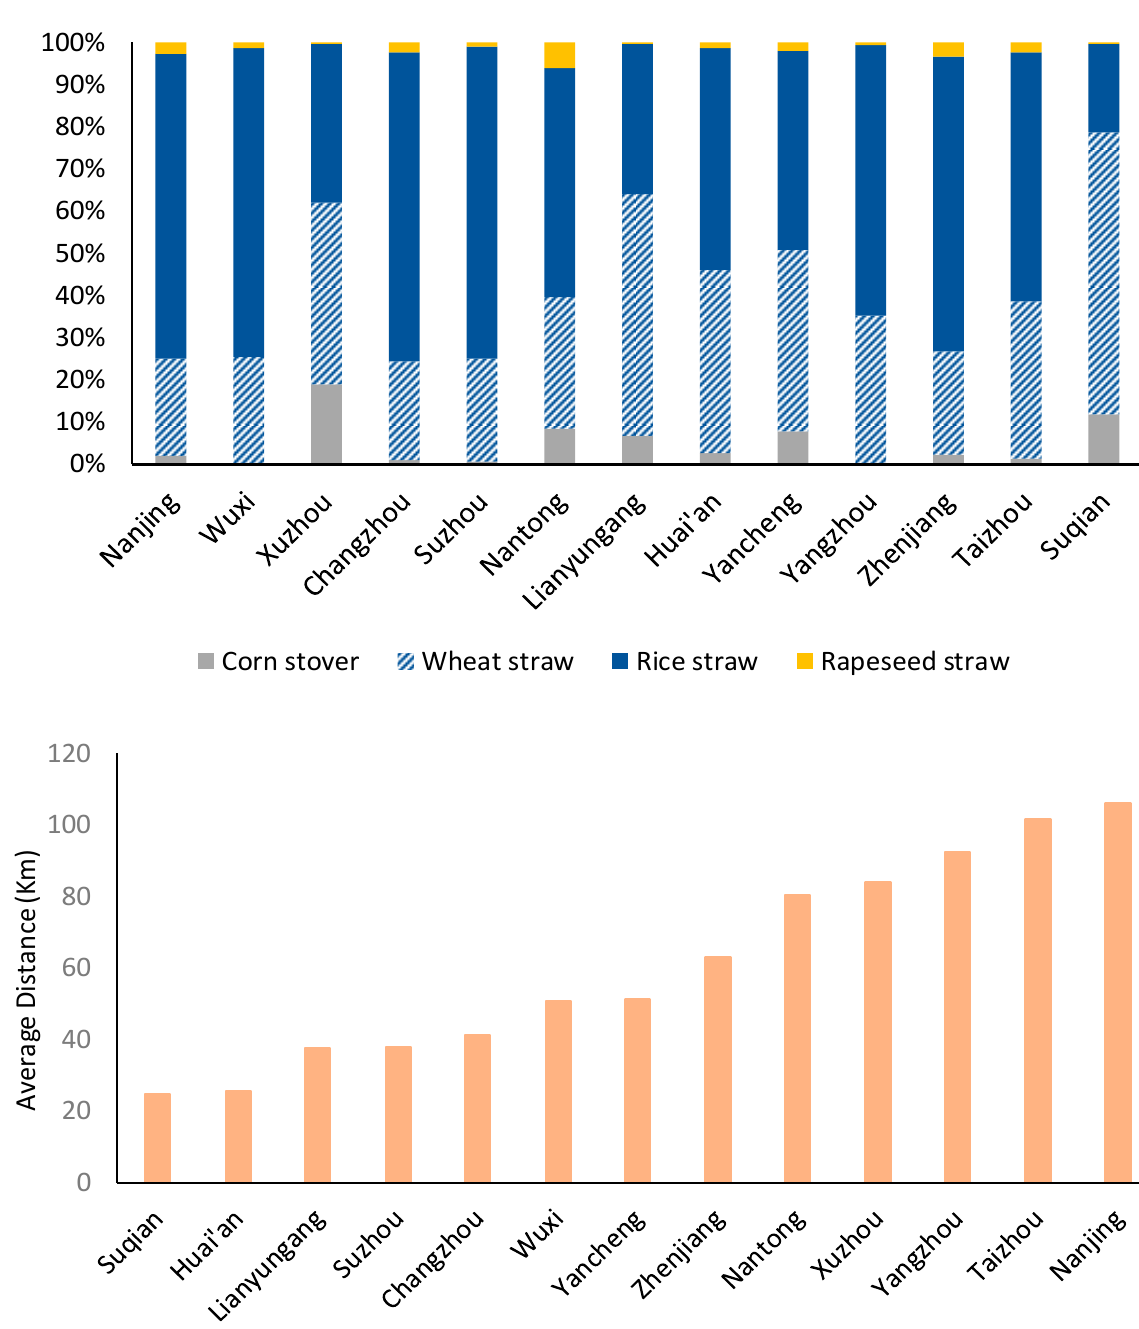
Figure 5. Biomass supply mix and average biomass hauling distances by facilities located in 13 cities at USD 80/MT biomass price and 10% co-firing rate: ( A ) Supply mix of biomass by city; ( B ) Average biomass transportation distance by city.